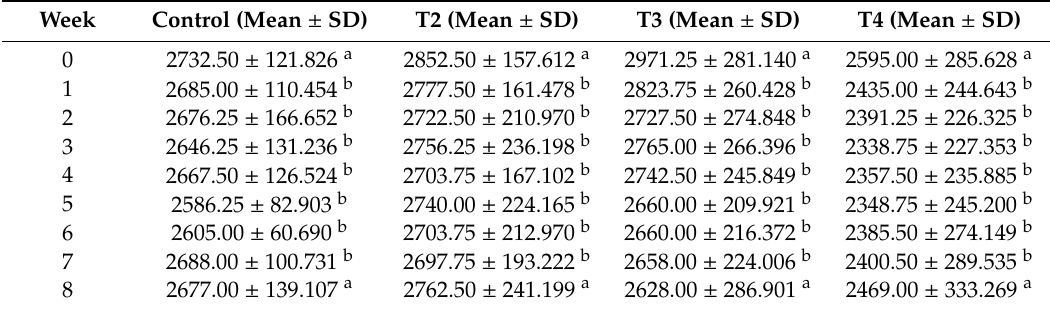
Table 2. Body mass of Agouti in various feed treatments groups over an 8-week